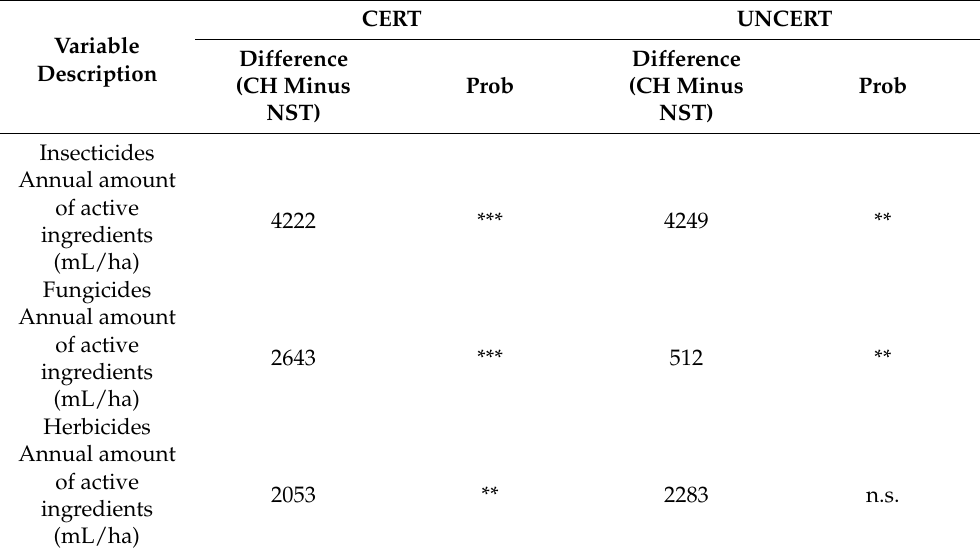
Table A4. Regional difference in the respondents’ pesticide use by farmer